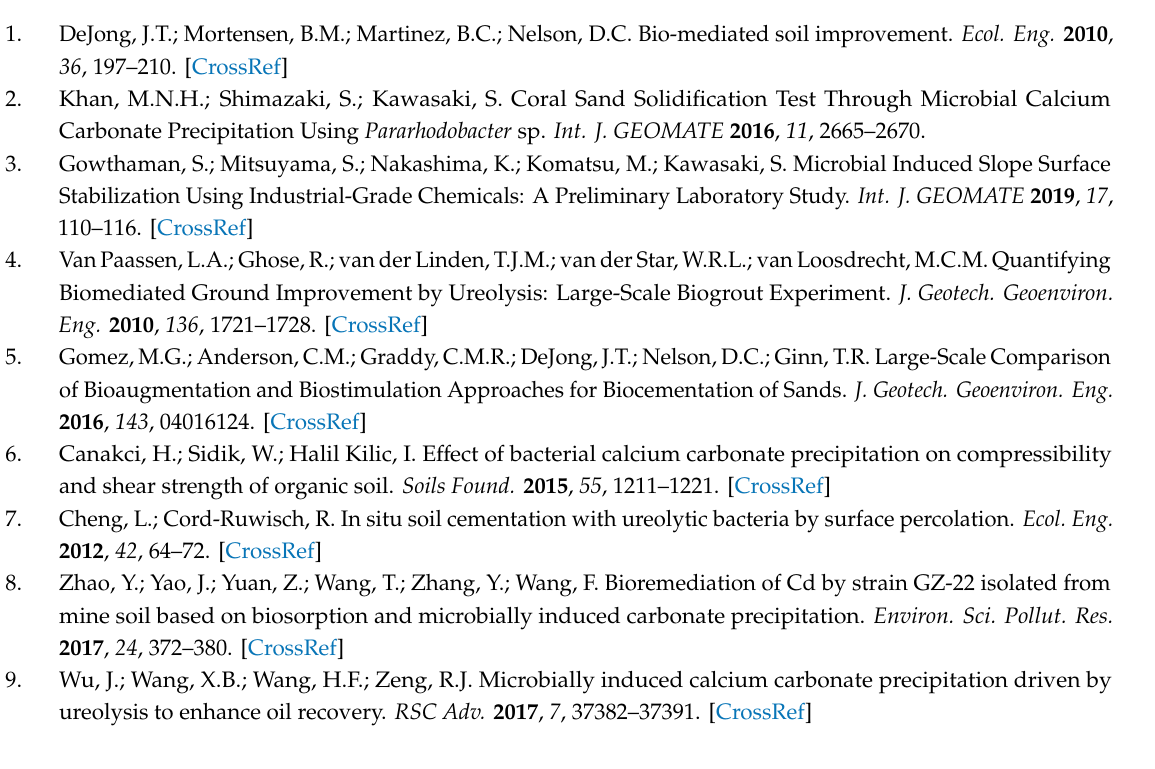
Figure S1: Location map and study area, Figure S2: Particle size distribution of natural beach sand, Figure S3: Experimental set up for the syringe sand solidification test, Figure S4: Bacterial cell concentration of isolated strains. Author Contributions: P.G.N.N. performed laboratory experiments, analysis, interpretation of data and original draft preparation; A.B.N.D. and K.N. provided technical assistance and reviewed and edited the manuscript; S.K. did primary supervision and helped in analyzing, methodical guidance, critical reviewing and approval of final version to be